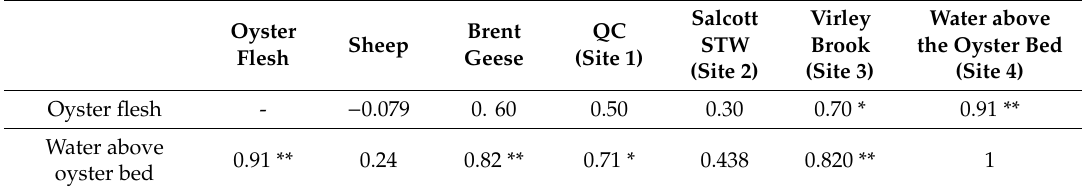
Table 6. Pearson correlation between sterols in oyster flesh and potential sources of faecal contamination, including water and animal faecal samples. The * and ** showed significant differences at 0.05 and 0.01, respectively.